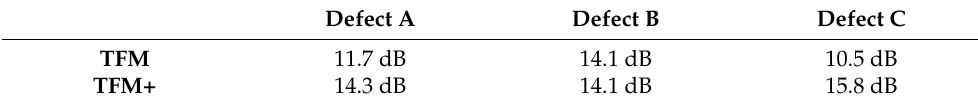
Table 2. Signal-to-noise ratio (SNR) for TFM and TFM+ flaw images shown in Figure 9.